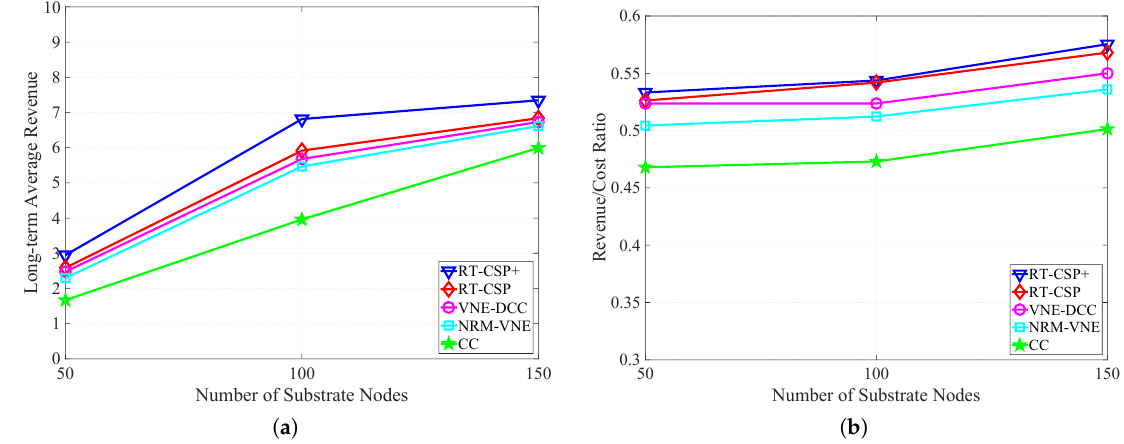
Figure 9. ( a ) Long-term average slice provisioning revenue in the different sizes of substrate network scenario; and ( b ) slice provisioning revenue-to-cost ratio in the different sizes of substrate network